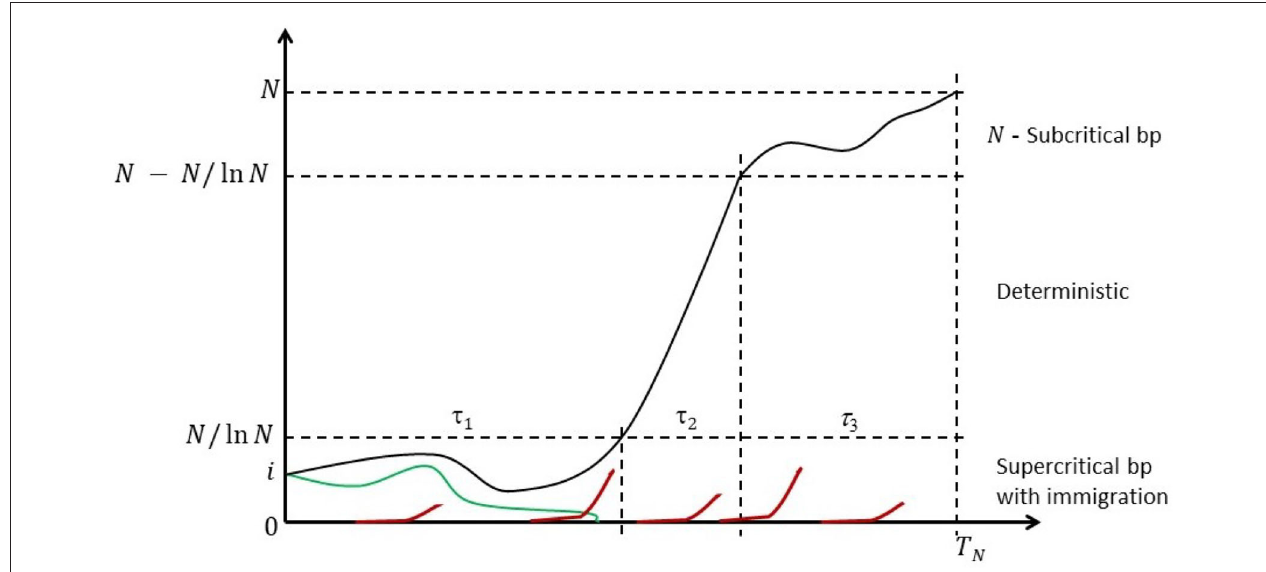
FIGURE 1 | Anatomy of the Moran process with recurrent mutations. Some mutant count trajectories may become transiently extinct (green line), but they will be resurrected by one of the recurring mutations events (red lines). Eventually the mutants are